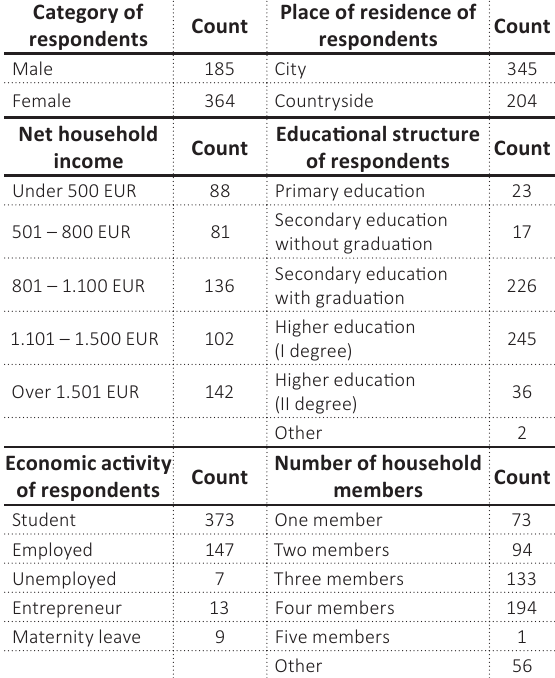
Table 2. Examined chocolate yoghurts and